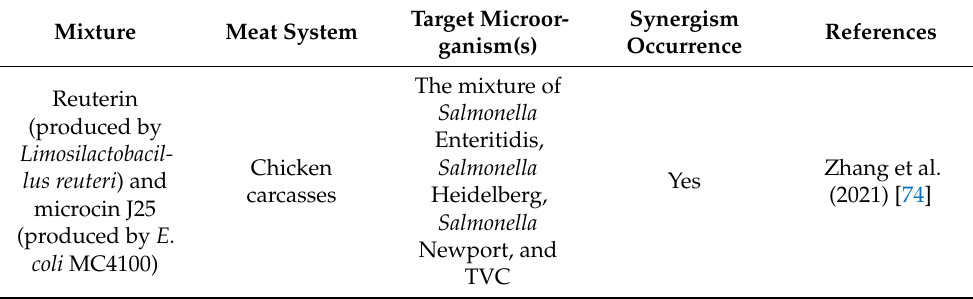
Table 6. The use of a combination of bacteriocin and BLIS against different target microorganisms.